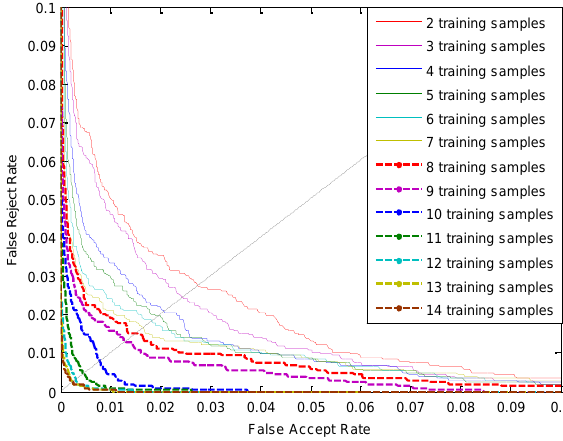
Figure 11. ROC curves by different number of training samples.